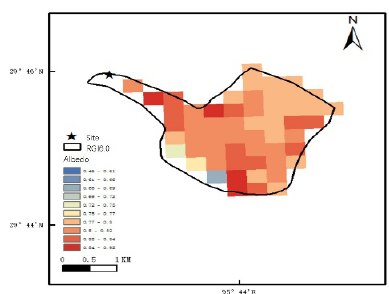
Figure 5. Sentinel-3 inversion of the albedo of 24K Glacier on March